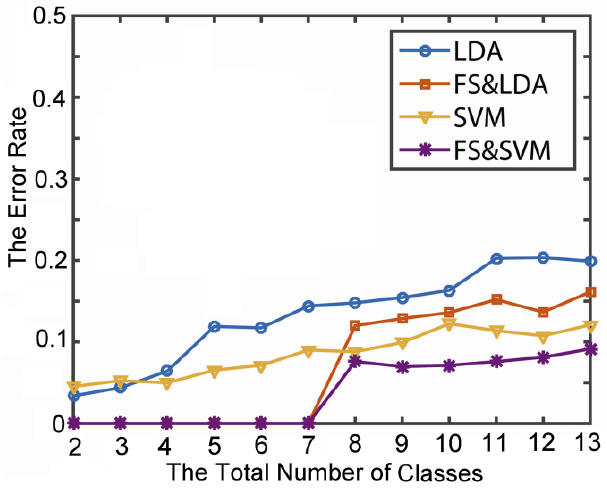
Figure 6. The average recognition error rate from cross-validation for 13 primitive